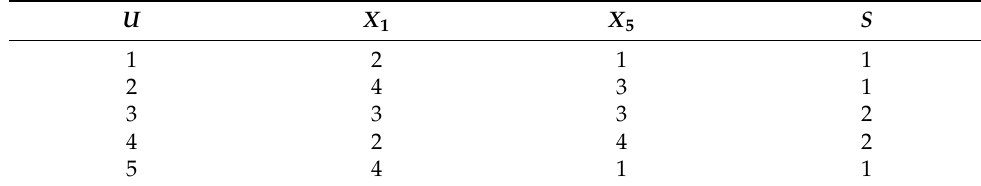
Table 5. The reduction information table.